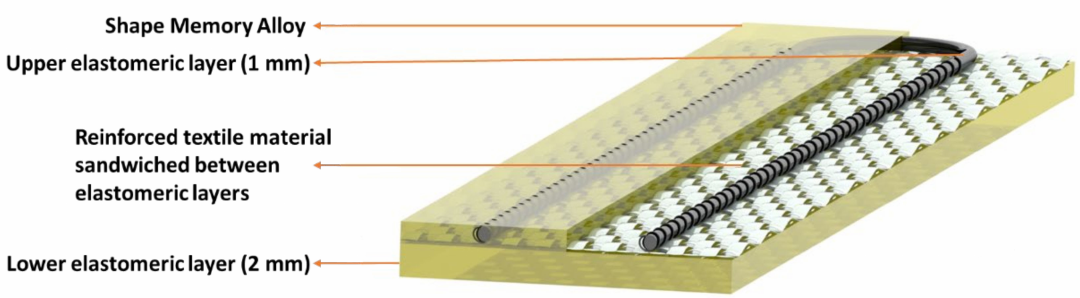
Figure 2. Graphical image showing the eccentric position of SMA-integrated textile in a multilayer actuator